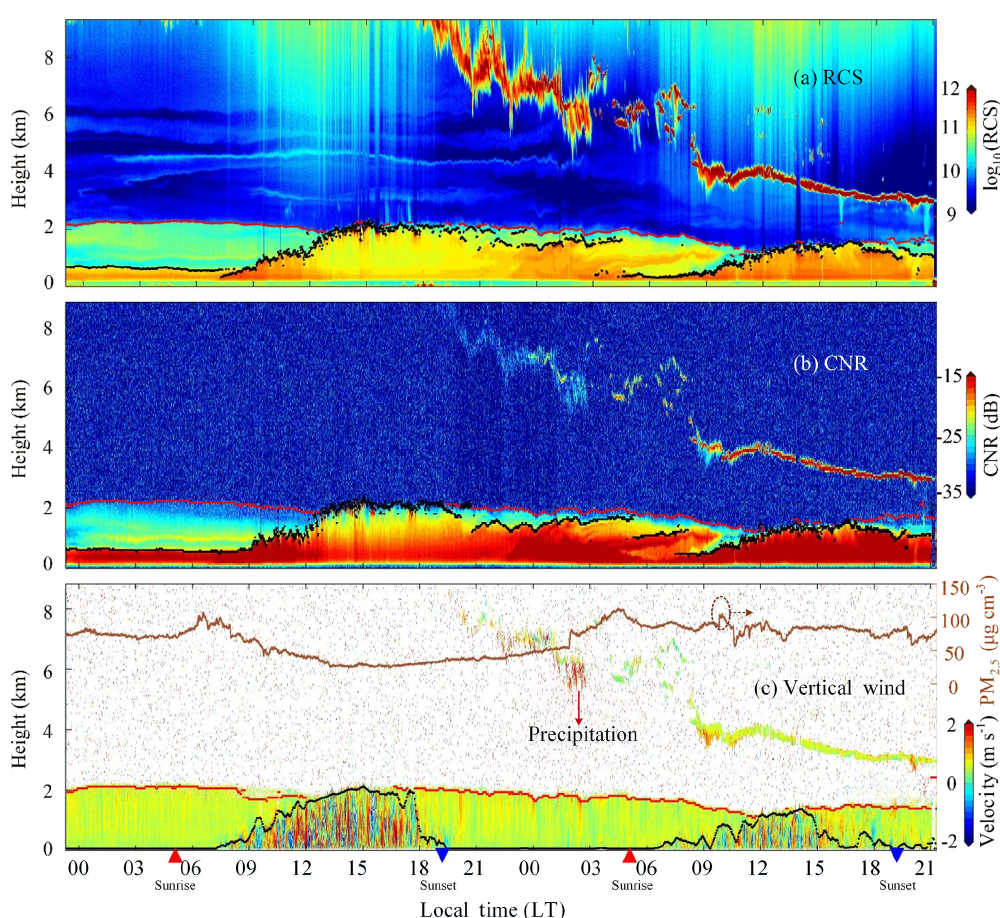
Figure 3. Lidar observational results from 1 June 2018 to 2 June 2018. (a) The 1min mean time series of logarithmic RCS profiles measured by DDL. The height time cross section of (b) CNR and (c) vertical wind measured by CDWL with 20s temporal interval. The downward (upward) vertical wind is positive (negative). The dotted brown line indicates the PM 2 . 5 concentration near the ground. The dotted black (red) lines in each panel indicate the BLH (RL tops) retrieved from RCS, CNR and vertical wind, respectively.